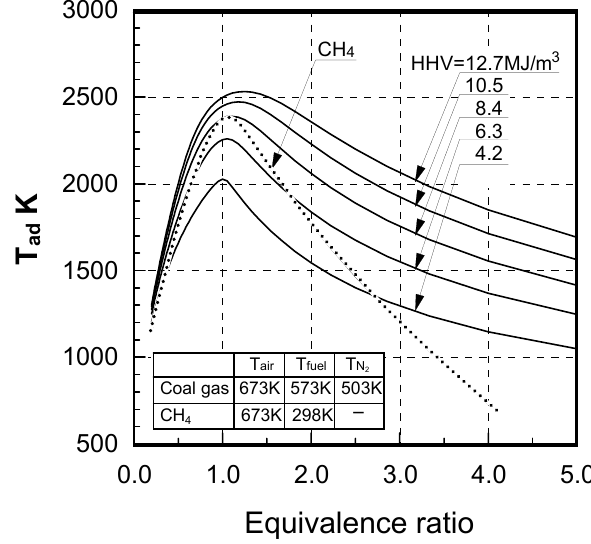
Figure 8. Relationship between equivalence ratio and adiabatic flame temperature for gasified fuels and CH 4